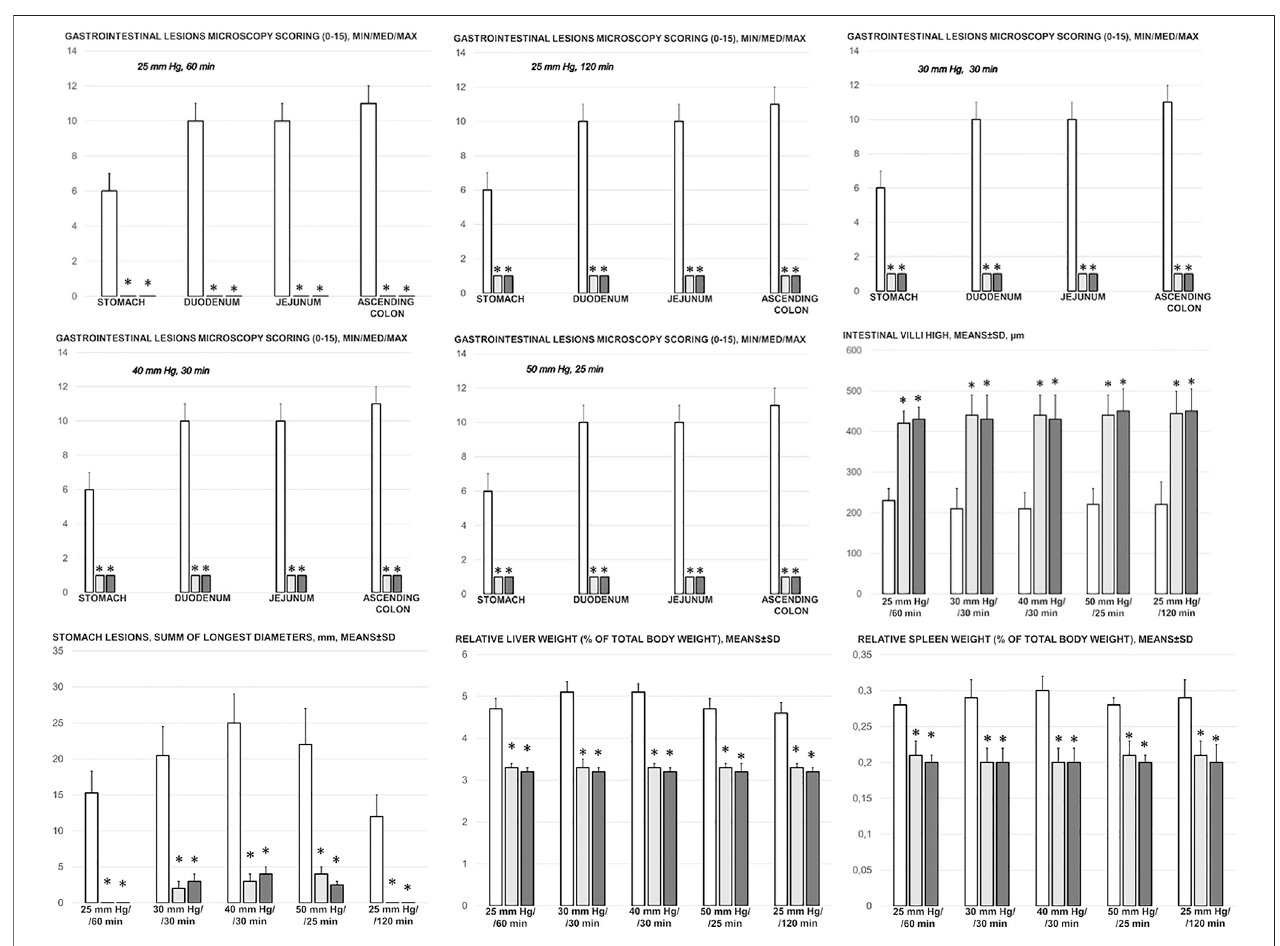
FIGURE 7 | Gastrointestinal lesions microscopy scoring (0 – 15), stomach, duodenum, jejunum, ascending colon and intestinal villi high, µm, and stomach lesions (sumoflongestlesionsdiameters,mm),relativeliverweight(%oftotalbodyweight),relativespleenweight(%oftotalbodyweight)inthethiopental-anesthetizedratswith the increased intra-abdominal pressures at 50 mmHg for 25 min, at 30 mmHg or 40 mmHg for 30 min, at 25 mmHg for 60 min increased intra-abdominal pressures- time, and in the esketamine-anesthetized rats with the increased intra-abdominal pressures at 25 mmHg for 120 min increased intra-abdominal pressures-time, following medication (BPC 157 10 μ g/kg (light gray bars), 10 ng/kg (dark gray bars); saline 5 ml/kg (white bars)) given subcutaneously at 10 min increased intra- abdominal pressures-time. Minimum (min), maximum (max), median (med), means ± SD, *P ˂ 0.05, vs.